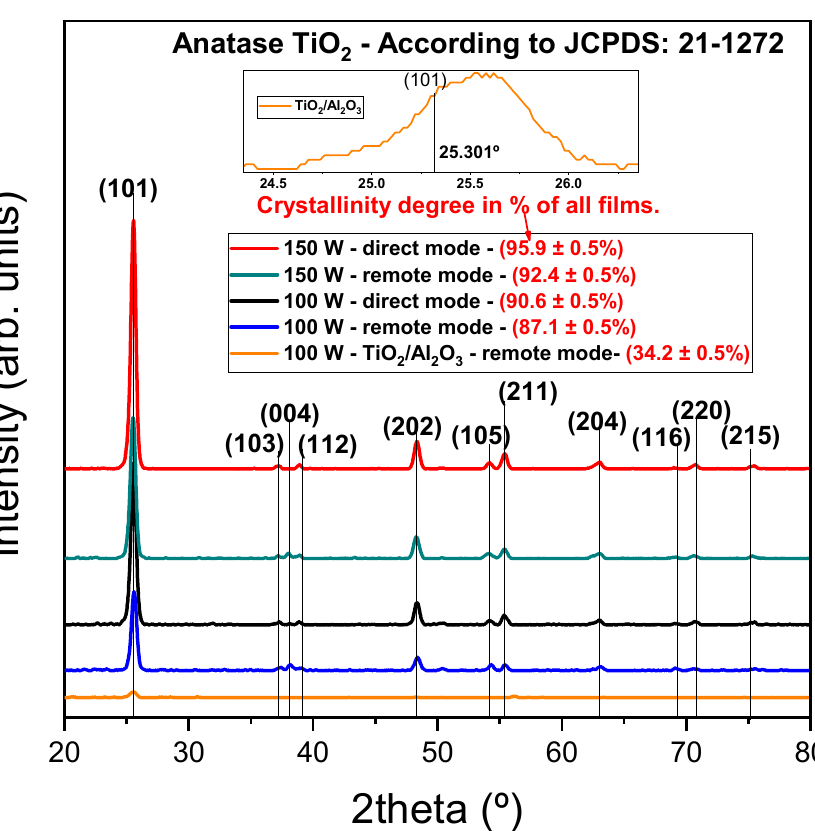
Figure 5. GIXRD diffractogram for TiO 2 films deposited under different conditions of RF power, plasma mode, and Al 2 O 3 partial-monolayer insertion. Indexed peaks are of the anatase phase. The inset figure shows the peak (101) for the 100 W—TiO 2 / Al 2 O 3 film.